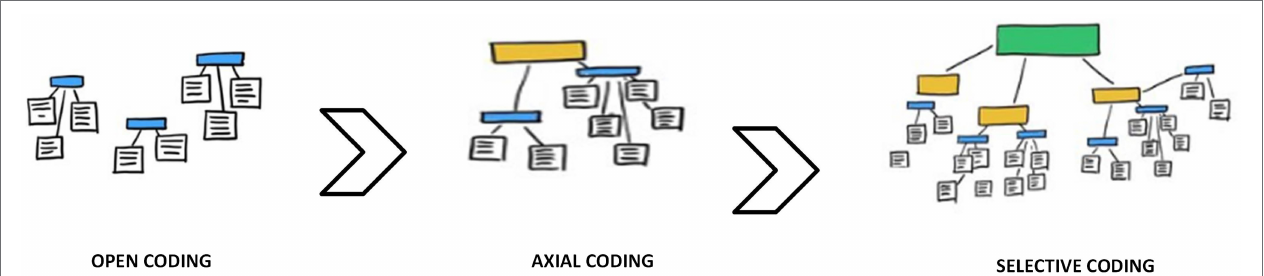
FIGURE 2 | Pictorial representation of Constant Comparative Method